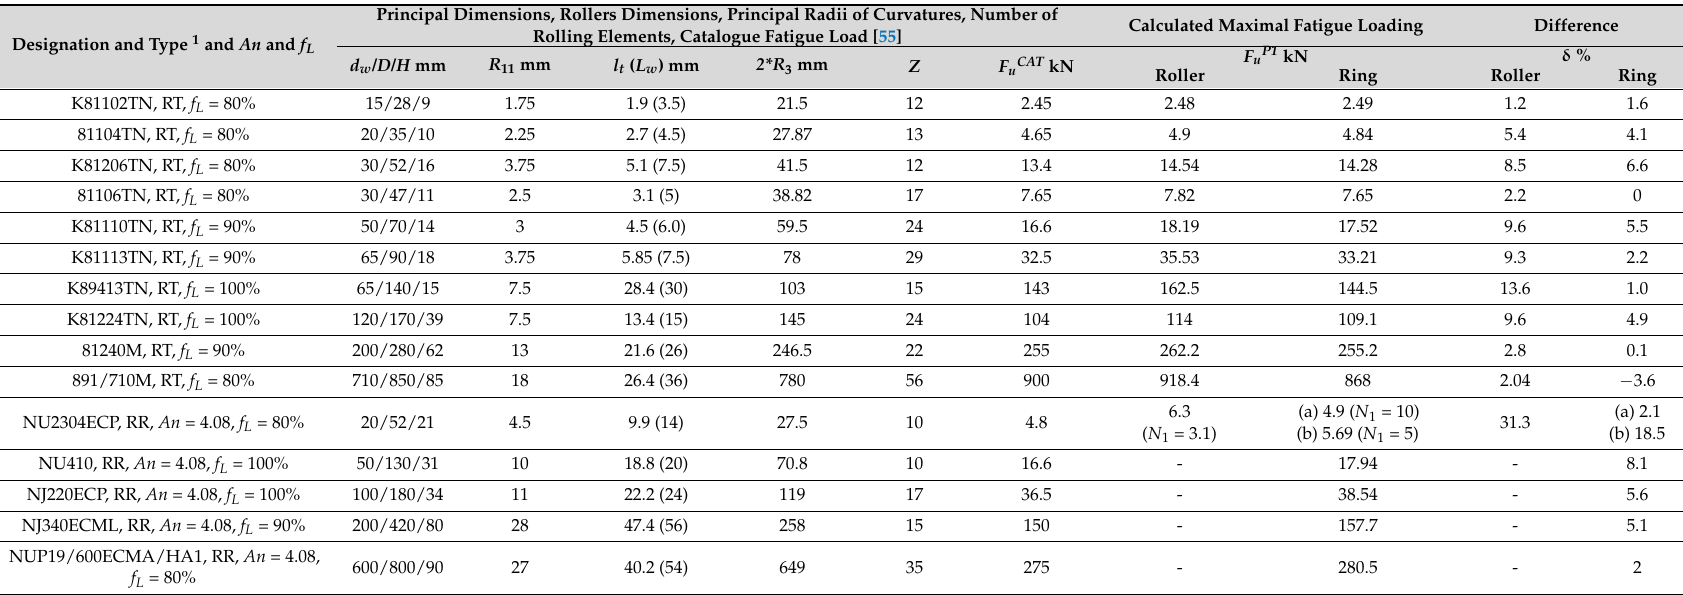
Table 2. Results of fatigue life calculations for roller bearings under an N 10% reliability condition concerning one million bearing rotations. Principal Dimensions, Rollers Dimensions, Principal Radii of Curvatures, Number of Rolling Elements, Catalogue Fatigue Load